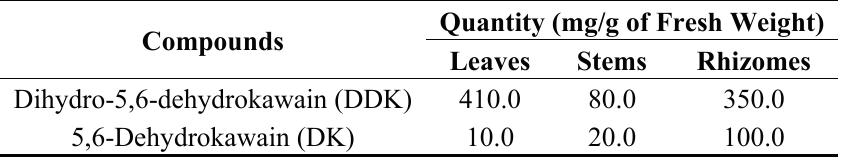
Table 2. DDK and DK contents in plant parts of Alpinia zerumbet